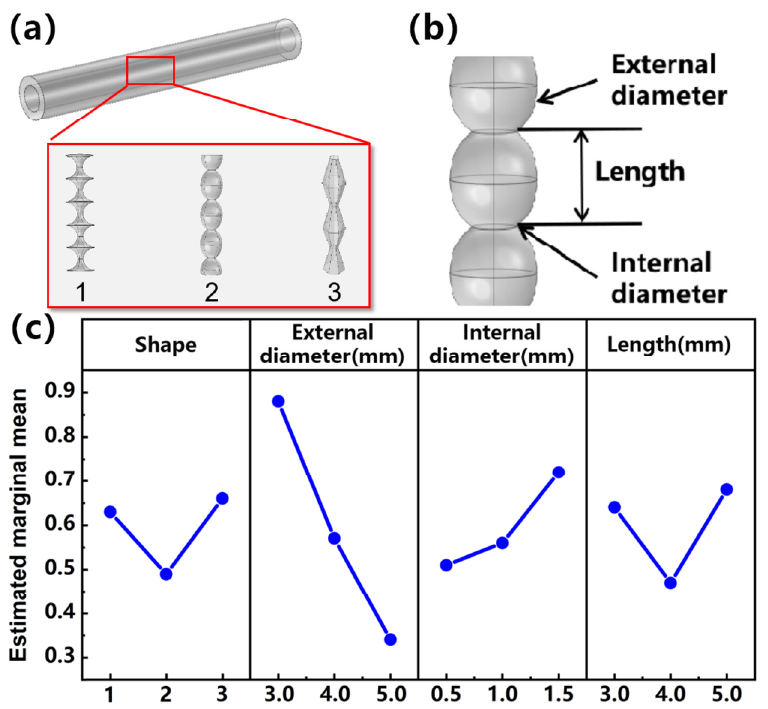
Figure 1. ( a ) Schematic diagram of three structures. ( b ) Structural parameters of the shape. ( c ) Re- of orthogonal sults of orthogonal experiment.